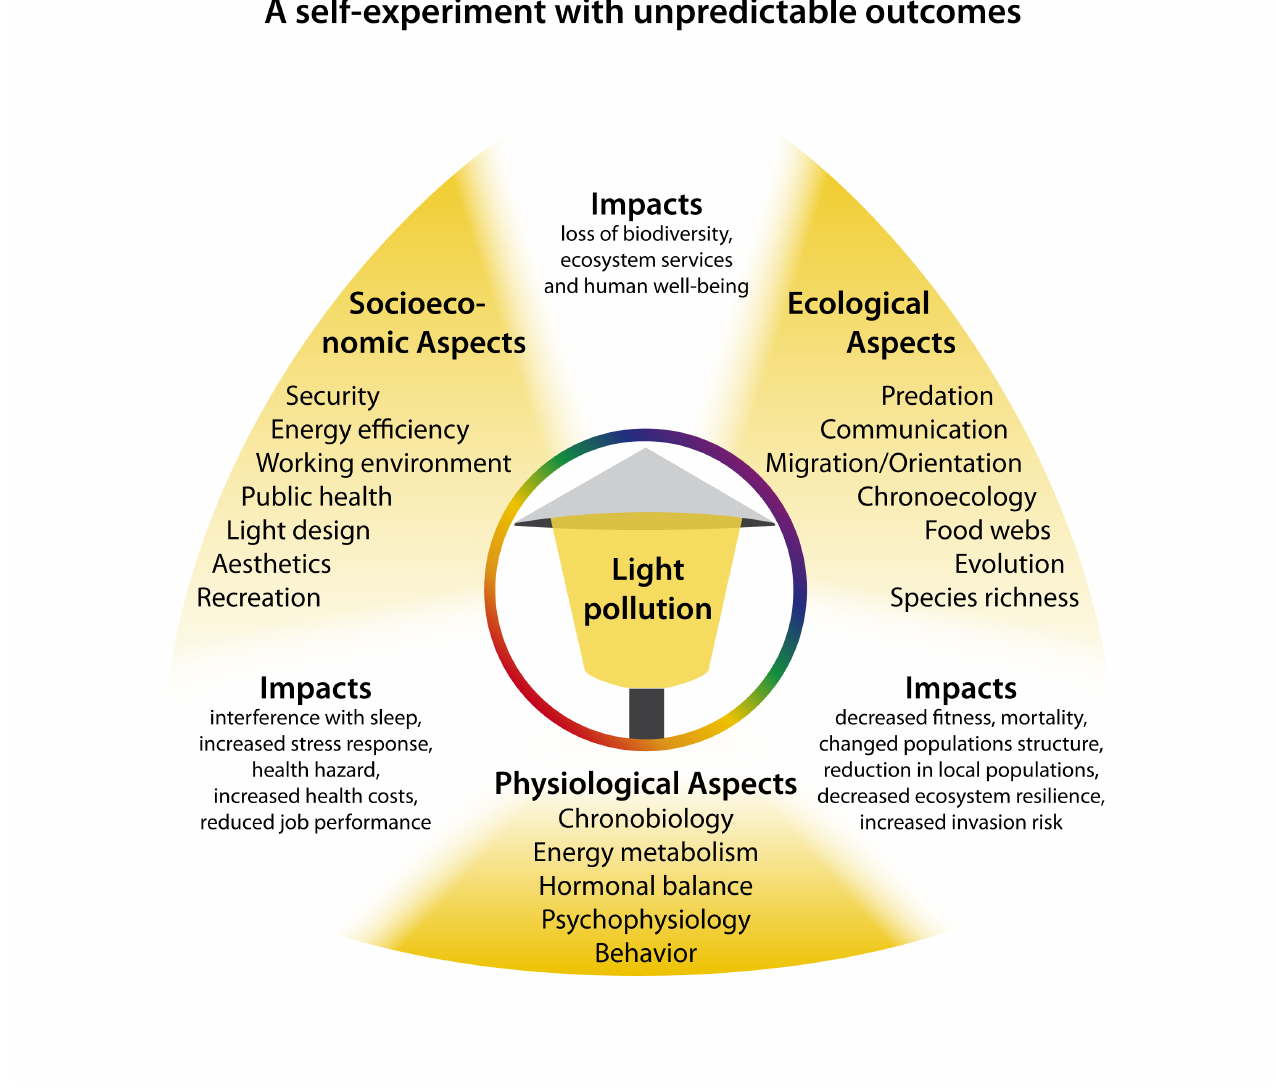
Fig. 1. Hypothetical impacts of exposure to artificial light at night. The main impacts, both with respect to light intensity and color spectra, emerge at the interfaces between the different physiological, ecological, and socioeconomic